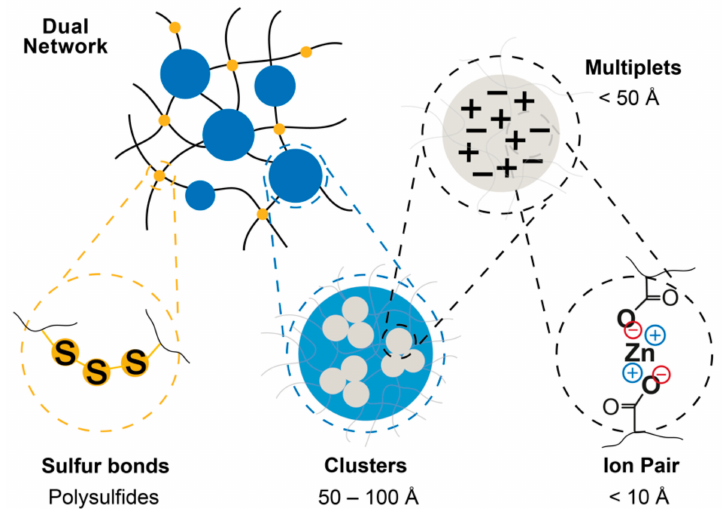
Figure 3. Scheme of the dual crosslinked networks. The scales in this figure are based on estimations in the Eisenberg model for ionomers [6], they may vary between different systems depending on the type of ionic pair and the processing conditions.